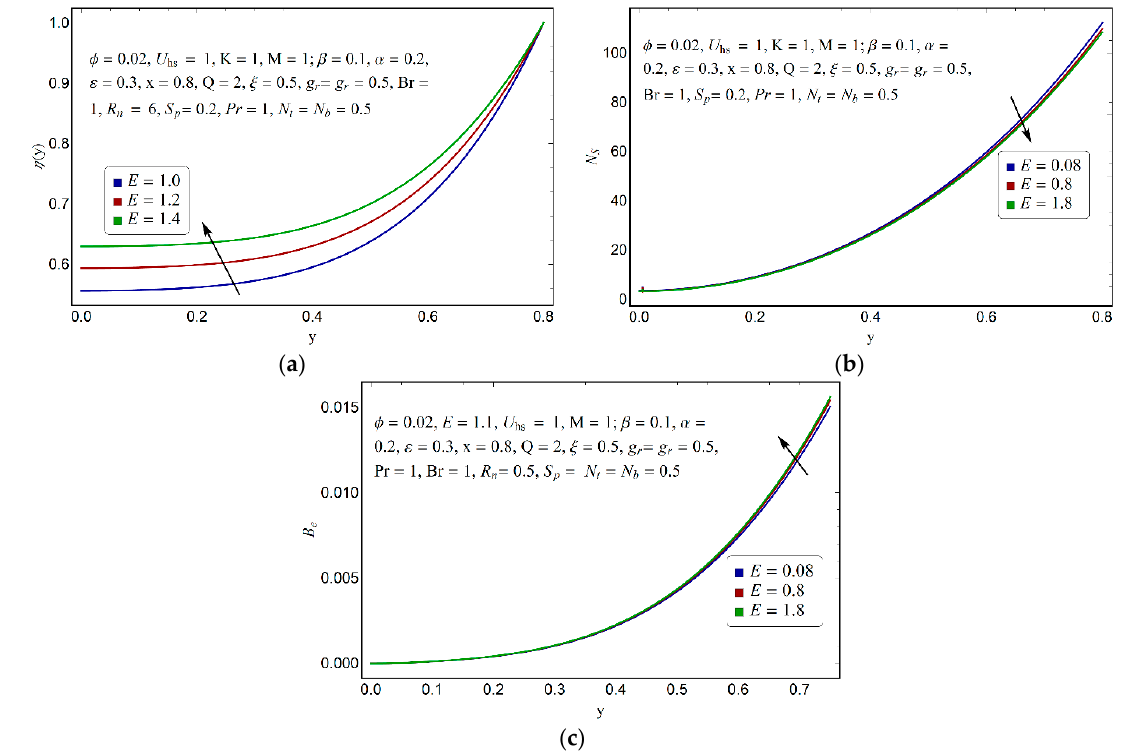
Figure 10. Effect of varying E on ( a ) the mass concentration profile, ( b ) the entropy number, ( c ) the Bejan number.